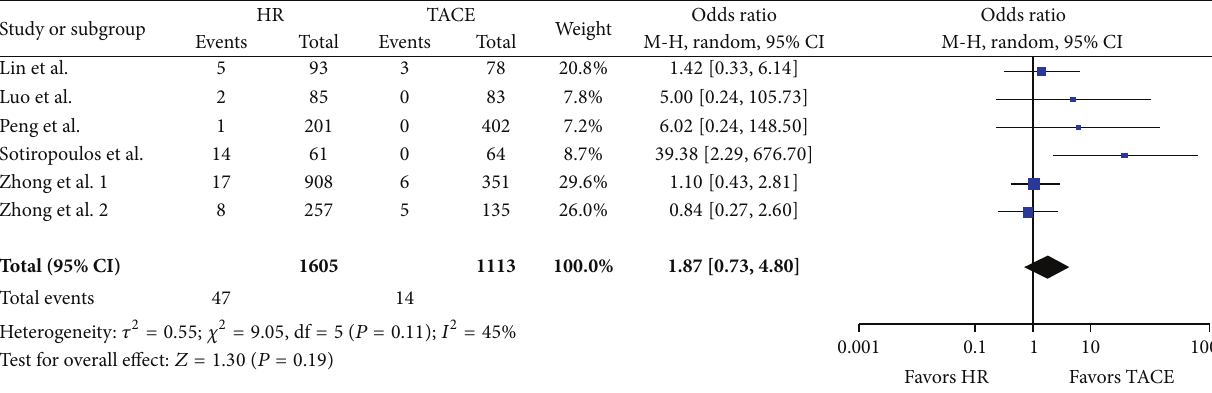
Figure 3: 30-day